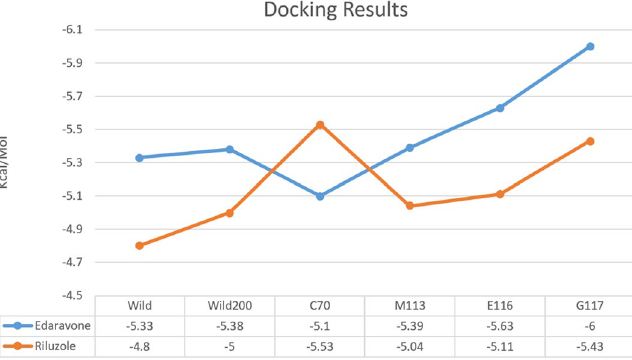
Figure 11. Binding energies (Kcal/Mol) of mutant forms of PFN-1 and PFN1 WT vs the two FDA-approved drugs for